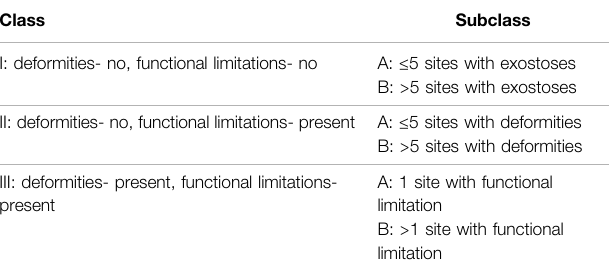
TABLE 1| Clinicalhereditarymultipleexostoses (HMEs)classi fi cationobtained via Switching Neural Networks approach, proposed by Mordenti et al. (2013).